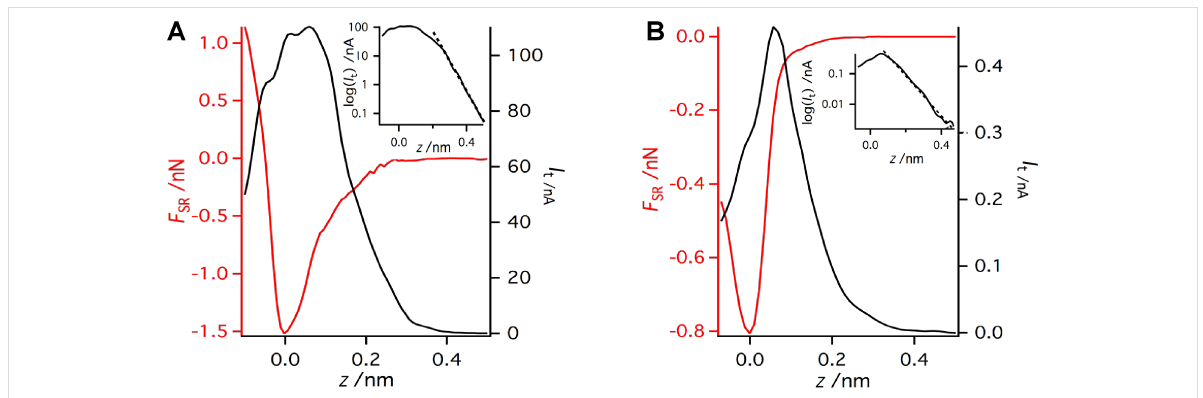
Figure 8: Two typically observed profiles of the dependence of the short-range interaction force ( F SR ) and the tunneling current ( I t ) on the tip–sample separation ( z ) with a logarithmic plot of I t in the inset. The first tip termination (A) presents a much stronger attractive short-range interaction than the second (B), and in addition the tunneling current is much smaller in case (B). The acquisition parameters are f 0 = 73180 Hz, a = 0.215 nm, k = 3750 N/m, and V bias = 0.4 V.